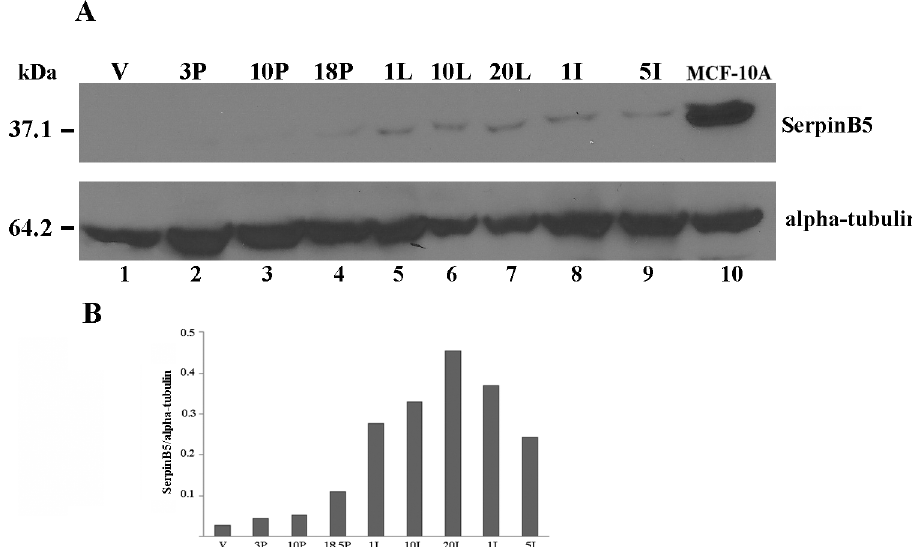
Fig 1. SerpinB5 expression is developmentally regulated in the mouse mammary gland. A. 100 μ g of protein extracts from mammary glands isolated on days 3, 10, 18 of pregnancy (3P, 10P and 18P), on days 1, 10 and 20 of lactation (1L, 10L and 20L), on days 1 and 5 of involution (1I and 5I) and from virgin mice (V), were subjected to 12% SDS-PAGE, transferred to PVDF membrane and probed with mouse monoclonal anti-SerpinB5 (Millipore). 50 ug of MCF-10A protein extract was loaded as a positive control (lane 10). The membrane was reprobed with anti-alpha-tubulin for loading control (lower panel); B. The bar graph shows SerpinB5 levels normalized by alpha-tubulin. This result is representative of 3 independent experiments done with two different mouse strains. P-SerpinB5-2 and P-SerpinB5-1 (Fig 2A, arrows). The third band has the highest electropho-